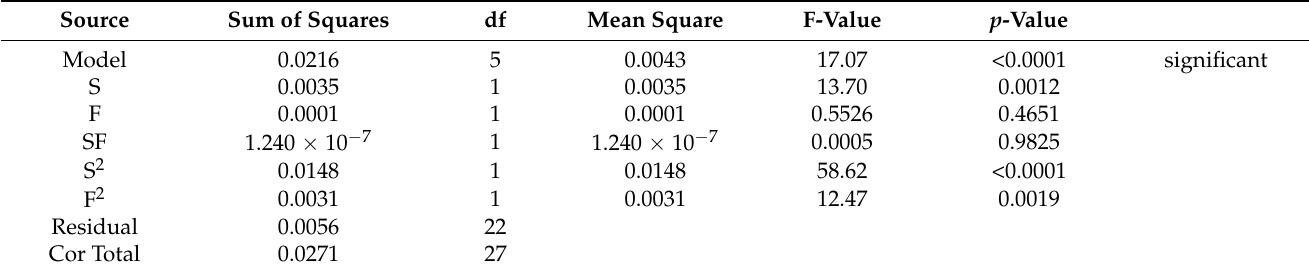
Table 10. ANOVA table for third output response